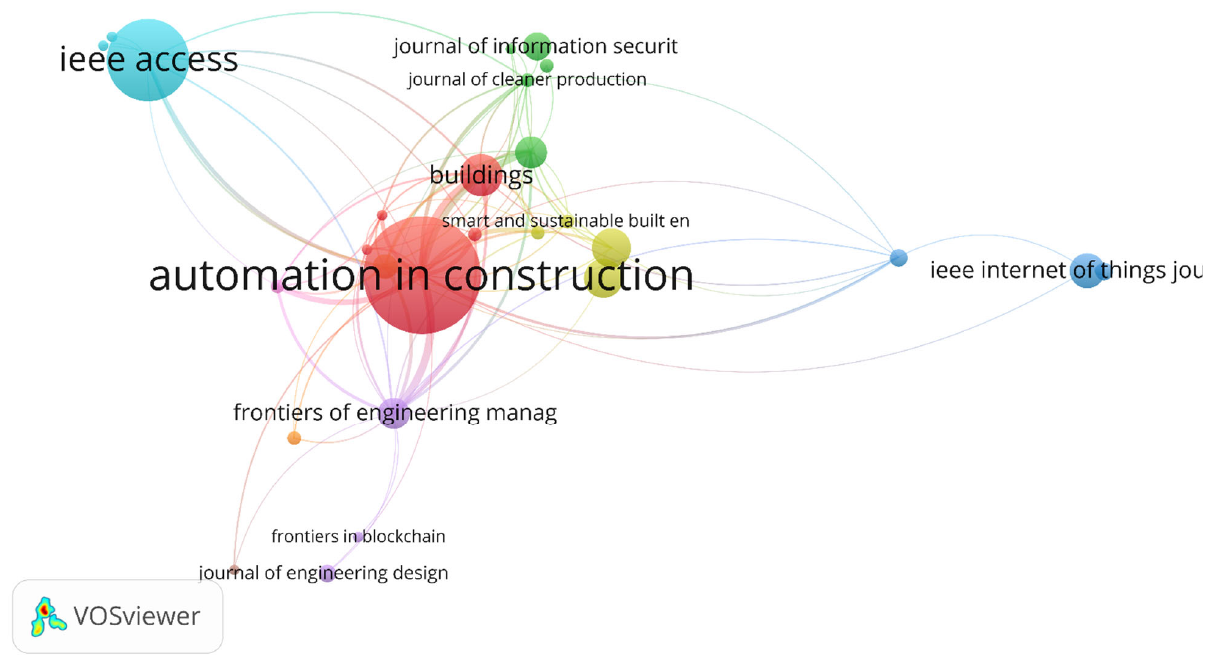
Figure 6. Network visualization of journals.